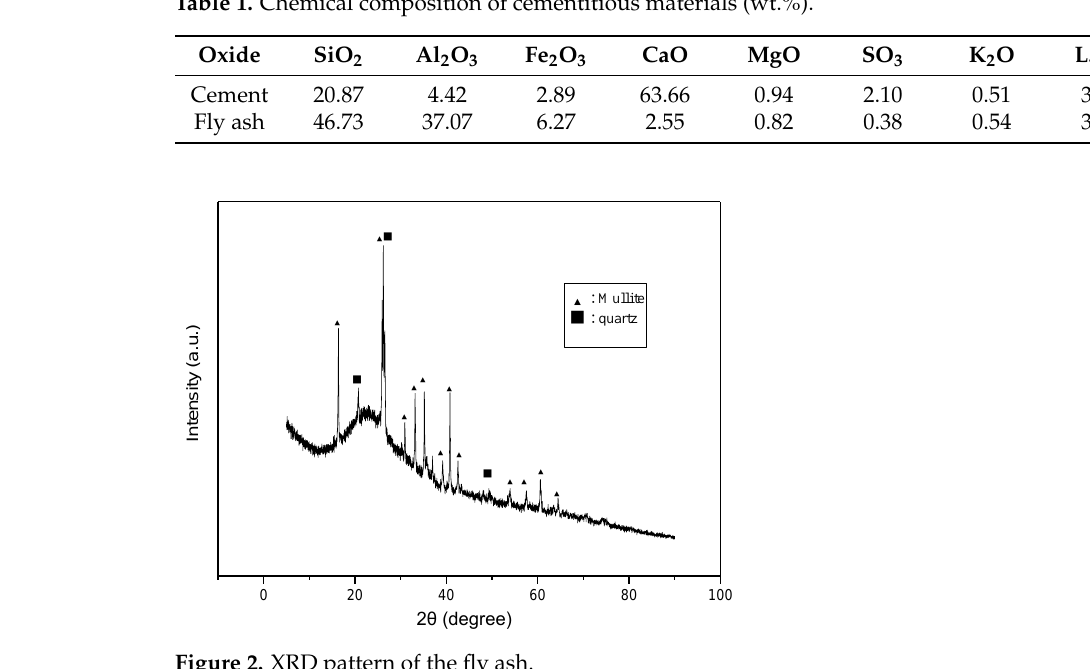
Table 1. Chemical composition of cementitious materials (wt.%).